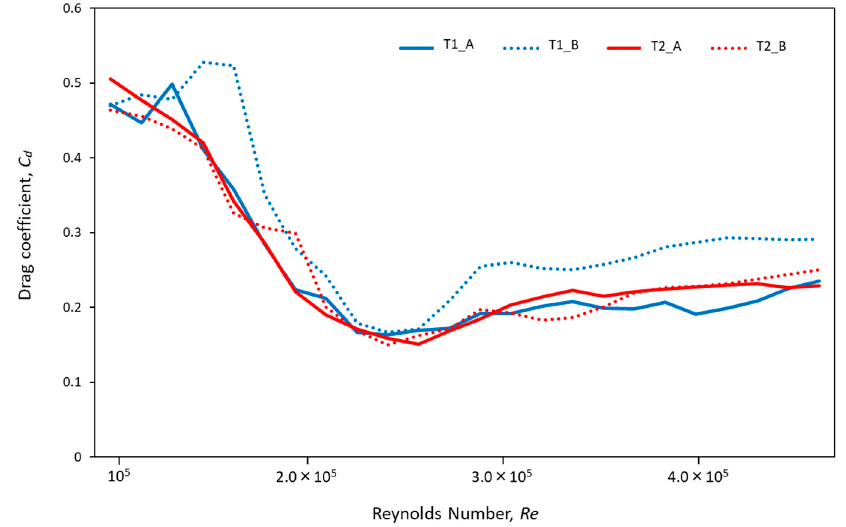
Figure 5. Drag coe ffi cient of the soccer Figure 5. Drag coefficient of the soccer balls.